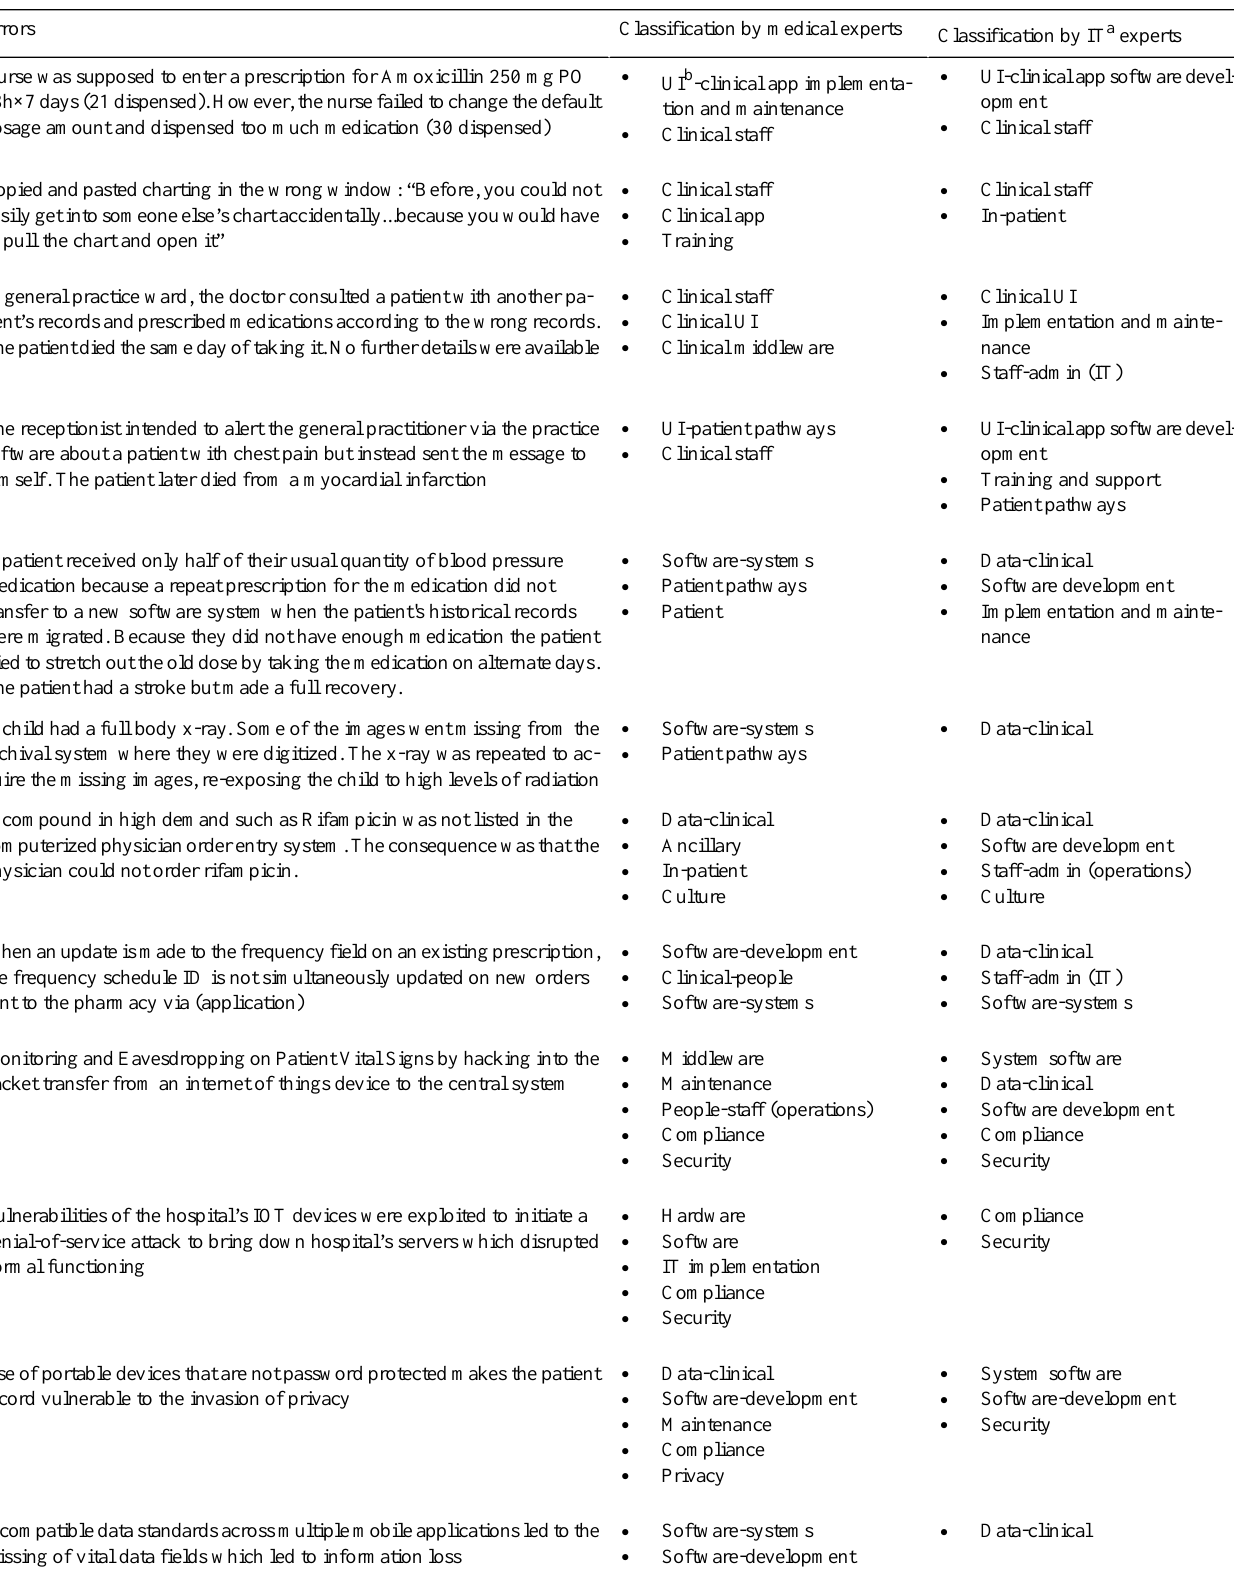
Table 2. Classification by medical and IT